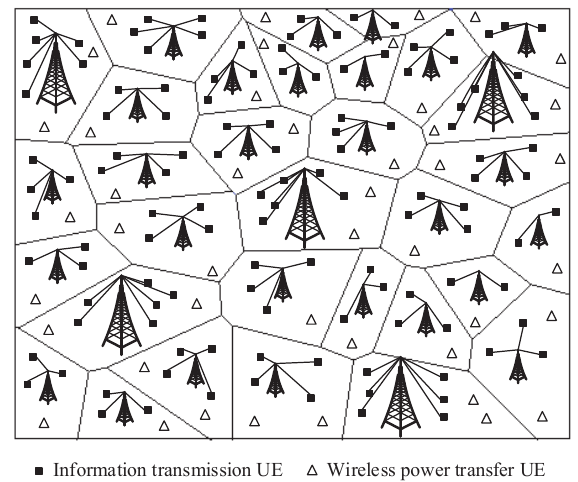
Figure 1. System model of a multi-tier heterogeneous wireless powered communication network